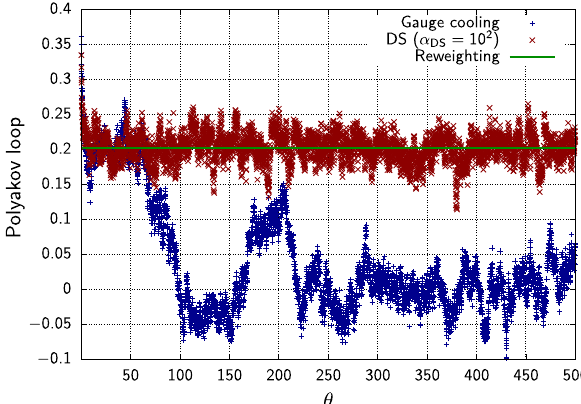
Fig. 2 The average Polyakov loop as function of the Langevin time for HDQCD on a 10 3 × 4 lattice, with κ = 0 . 04, β = 5 . 8, μ = 0 . 7 and α = DS